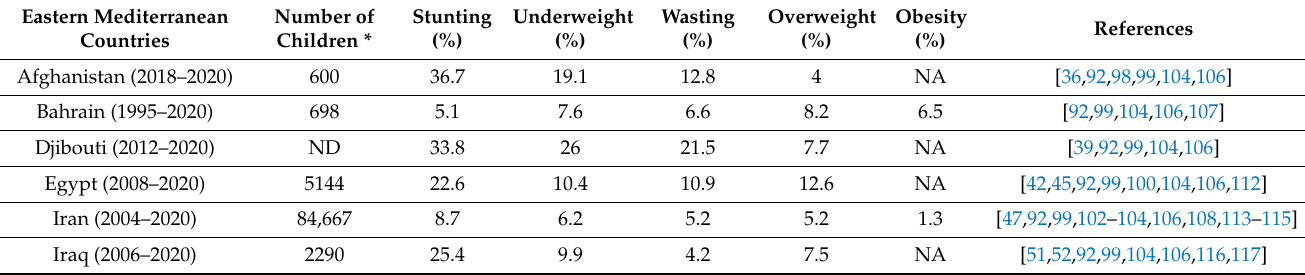
Table 2. Prevalence of malnutrition in the